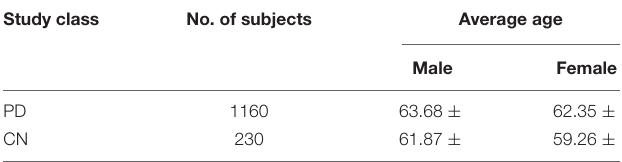
TABLE 2 | Dataset of DaTscan SPECT